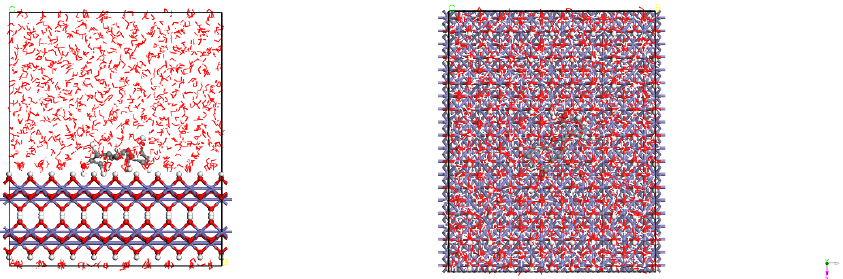
Figure 16. The adsorption configuration of luteolin molecule on γ -FeOOH (010) surface.